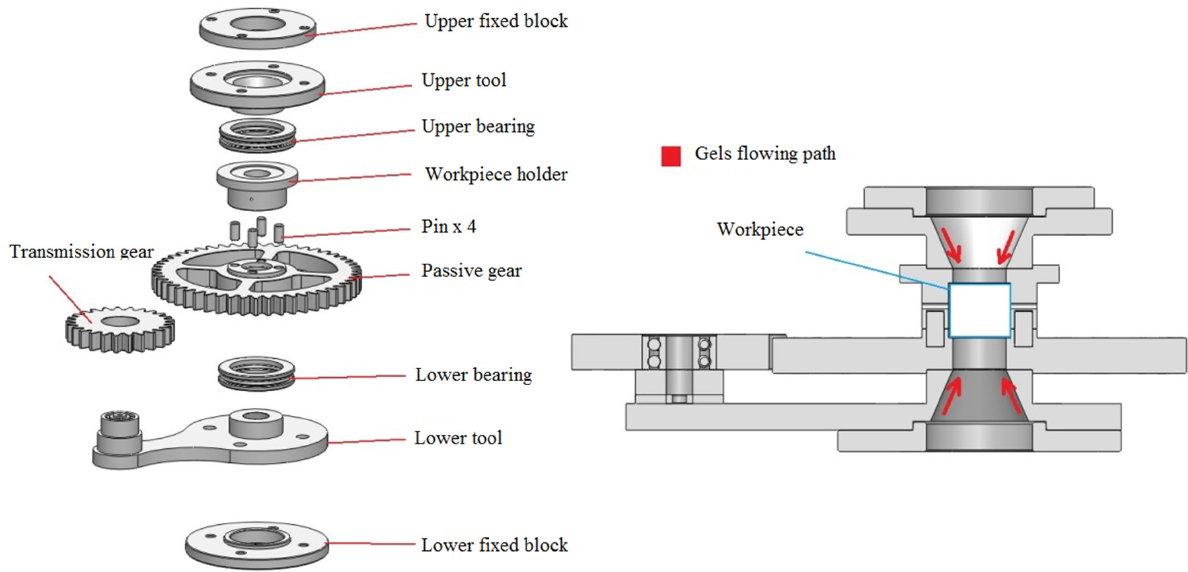
Figure 2. Design diagrams of a rotational mechanism with a gear assembly .